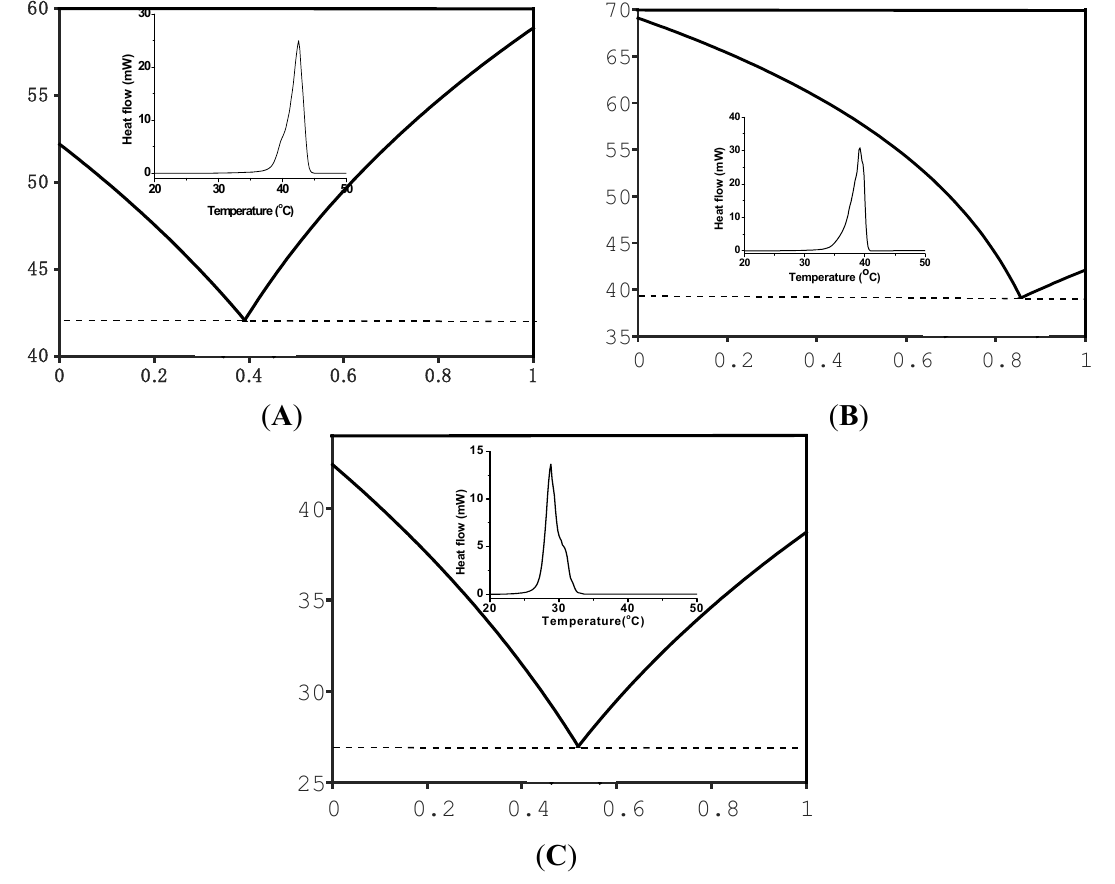
Figure 4. Calculated phase diagram and DSC curves (inset). ( A ) palmitic acid and myristic acid; ( B ) the eutectic mixture of two acids ( i.e. , palmitic acid and myristic acid) and stearic acid; ( C ) the eutectic mixture of three acids ( i.e. , palmitic acid-myristic acid-stearic acid) and lauric